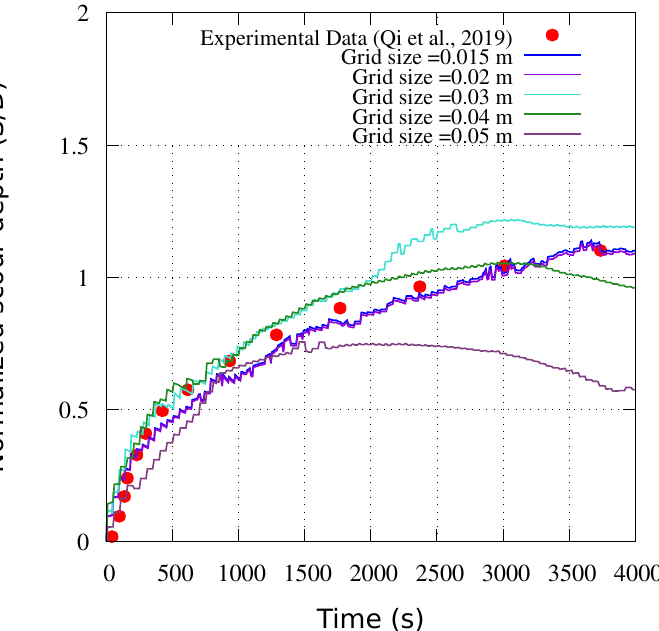
Figure 3. Grid convergence study for the phenomenon of scour around a group of piles in an environment affected by both waves and currents. Red line represents the numerical results, while the discrete points represent the experimental results acquired by Qi et al.